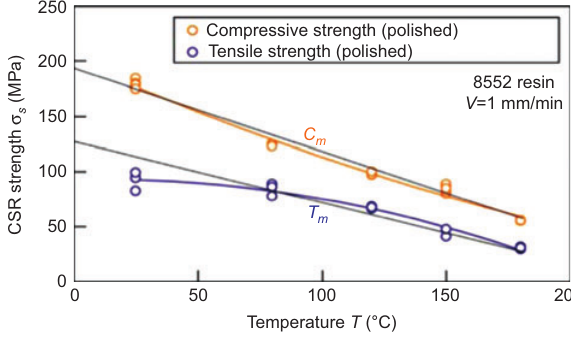
Figure 16 Flexural fatigue strength master curves for T700 and T700 carbon fabrics and vinyl ester resin system (data generated by Figure 15 Tensile ( T ) and compressive ( C ) strengths master m m curves for Hexcel 8552 resin system (data generated by Miyano).